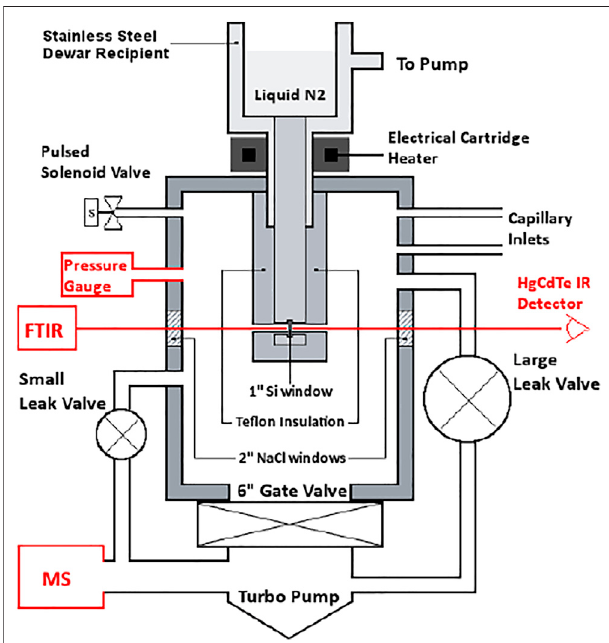
FIGURE 10 | Schematic drawing of stirred- fl ow reactor (SFR) with two escape ori fi ces equipped with FTIR transmission across a temperature- regulated 1 ″ Ø Silicon window in a multidiagnostic arrangement (FTIR absorption of solid substrate fi lm, MS residual gas detection, 1 Torr full scaleBaratronpressuregauge).ThetransmissionwindowsfortheIRradiation are 2 ″ Ø NaCl windows. Inlets are either continuous fl ow across capillaries, fi ne needle valve or pulsed solenoid valve for short gas